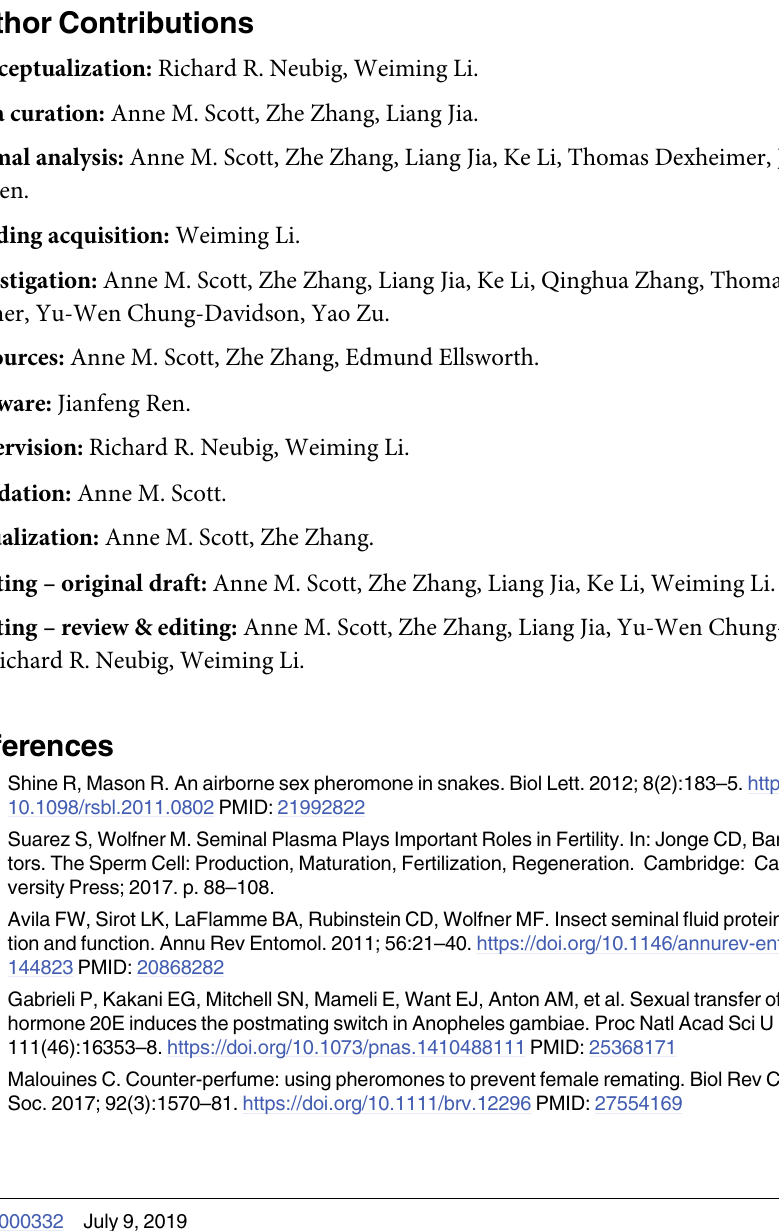
S2 Table. Spermine structural analogs screened as TAAR348 spermine receptor antago- nists and agonists. CAS, Chemical abstract service; TAAR, trace amine-associated receptor. (DOCX) S1 Data. Excel spreadsheet containing, in separate sheets, the underlying numerical data for figures in the main text and supplementary information.